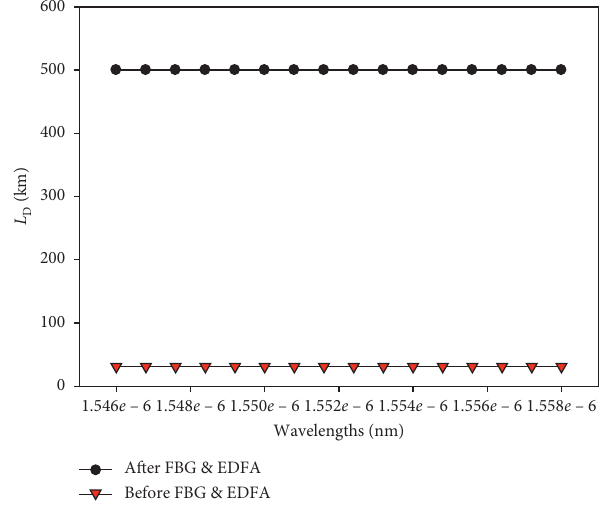
Figure 9: Variation of L D at different values of